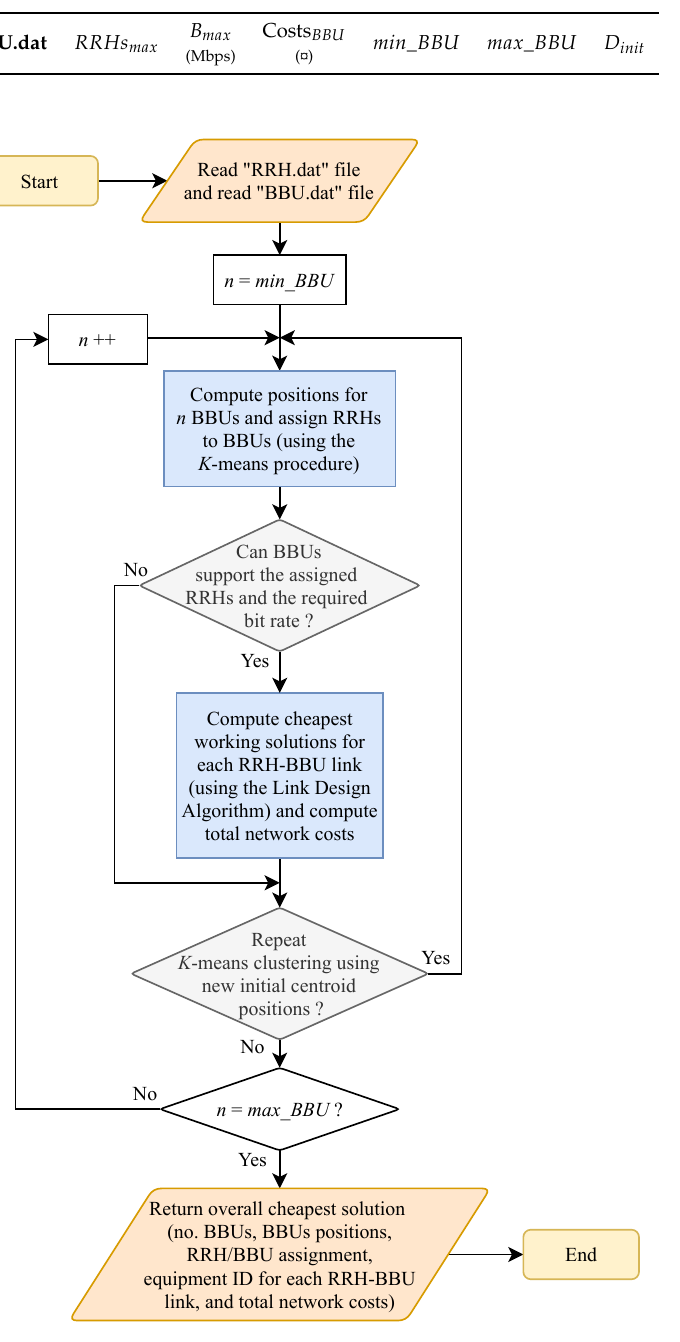
Figure 3. Flowchart of the network planning